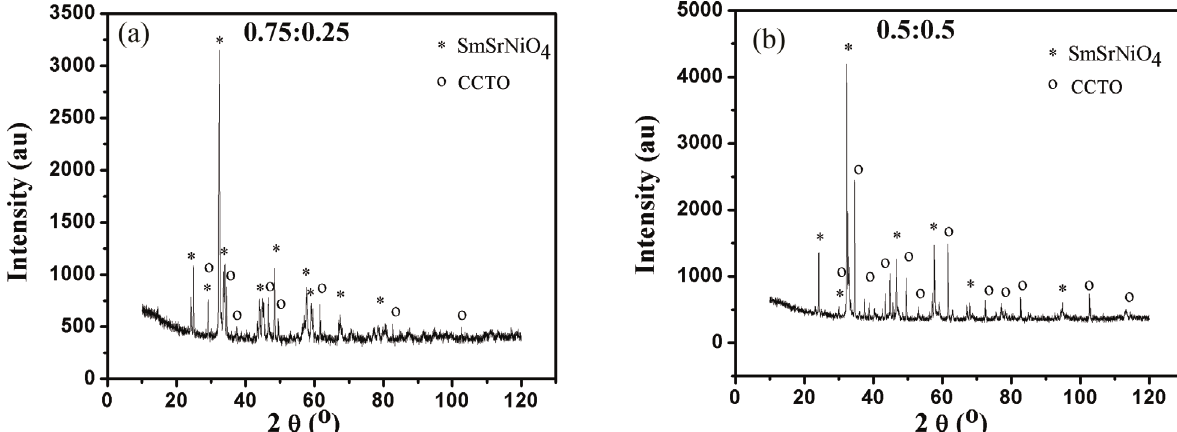
Figure 2. XRD patterns of ( a ) SmCTO25 and ( b ) SmCTO50 composites.